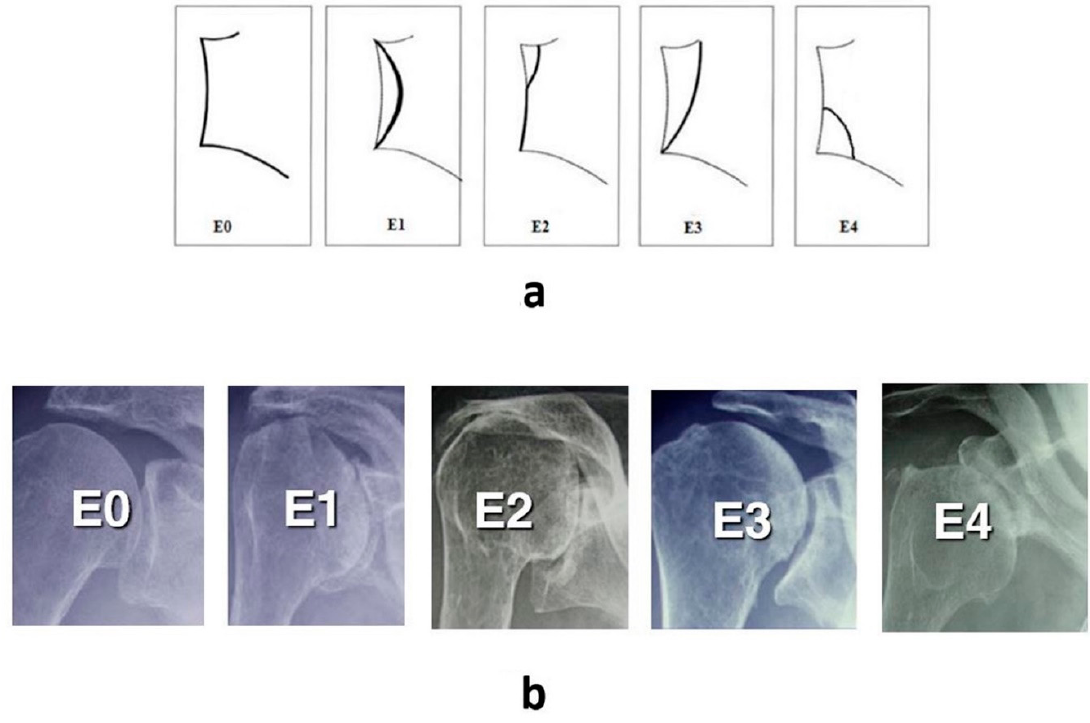
Figure 1. Favard et al.’s classification of the di ff erent types of glenoid erosion depicted schematically ( a ) and radiographically ( b ). The classification progresses from E0 to E4. E0: superior humeral head migration with no glenoid erosion; E1: concentric medialized glenoid erosion; E2: glenoid erosion predominantly in the superior pole; E3: global glenoid erosion more severe in the superior pole; E4: glenoid erosion predominantly in the anteroinferior pole.